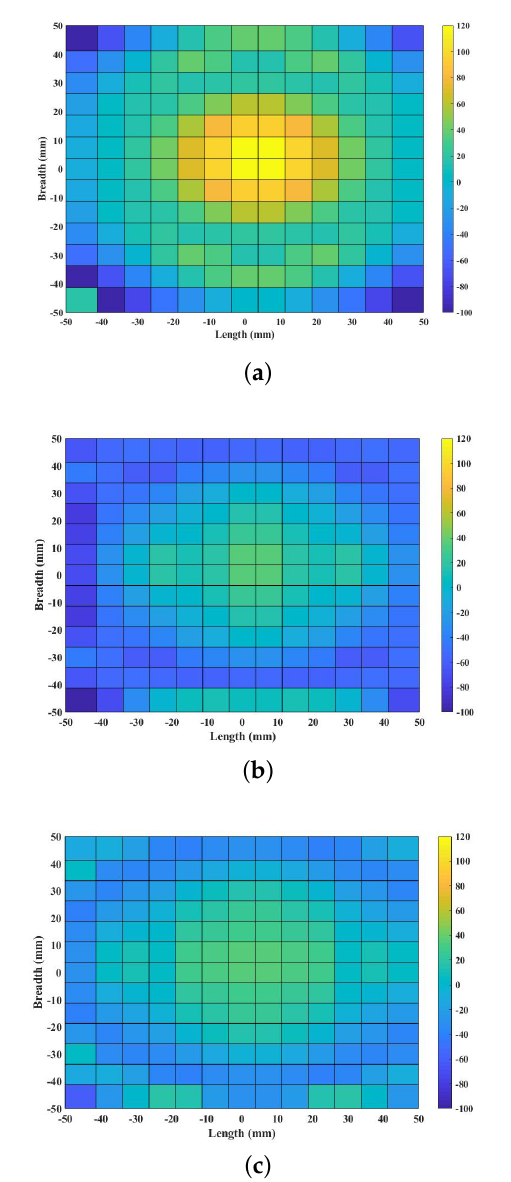
Figure 4. ( a ) Aperture phase distribution noted in Reference Plane 1, ( b ) improvement in aperture phase observed in 2D phase distribution over the aperture recorded in Reference Plane 2 before correction in BES, and ( c ) phase distribution over the aperture recorded in Reference Plane 2 after correction in BES.